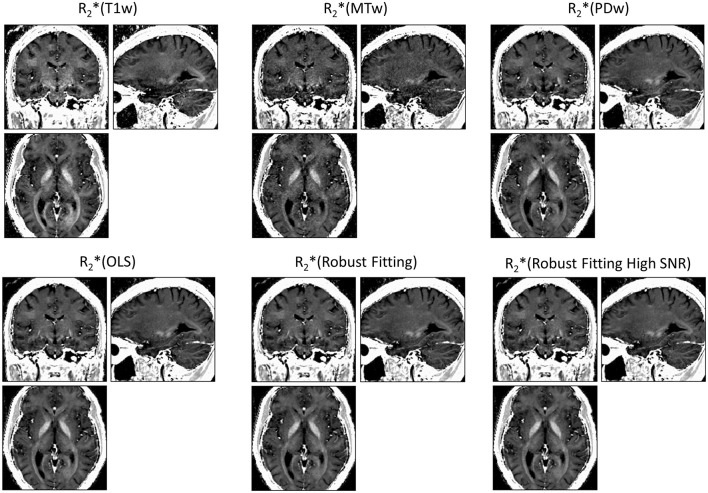
R2* maps estimated from multi-echo FLASH data unaffected by motion. ESTATICS improved the SNR and delineation of contrast edges even when there were no significant motion artifacts apparent. See Figure 1 for further details. All maps are windowed from 5 to 50 s−1.